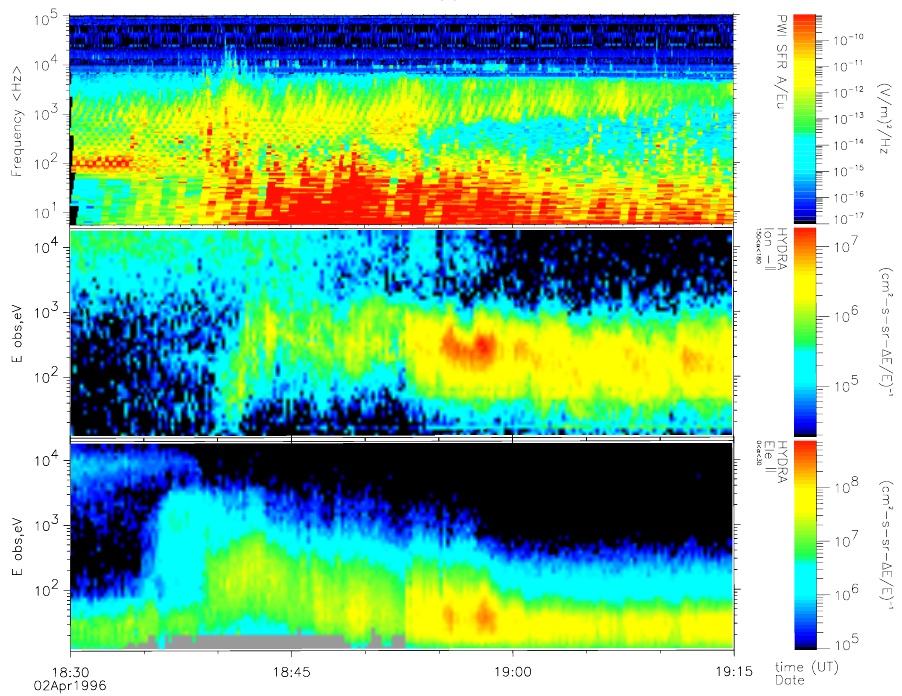
Fig. 1. Spectrograms of the Polar HYDRA electron and ion energy flux and the PWI electric field spectral density for a pass of the Polar spacecraft on 2 April 1996. The top panel is the PWI data from the SFR which shows the typical signatures of cusp whistler mode hiss. The second panel is upward ion flux density and the bottom panel is Earthward electron flux density. Seen in this figure is the cusp signature of low energy, high density plasma that begins at about 18:52:30 UT and continues